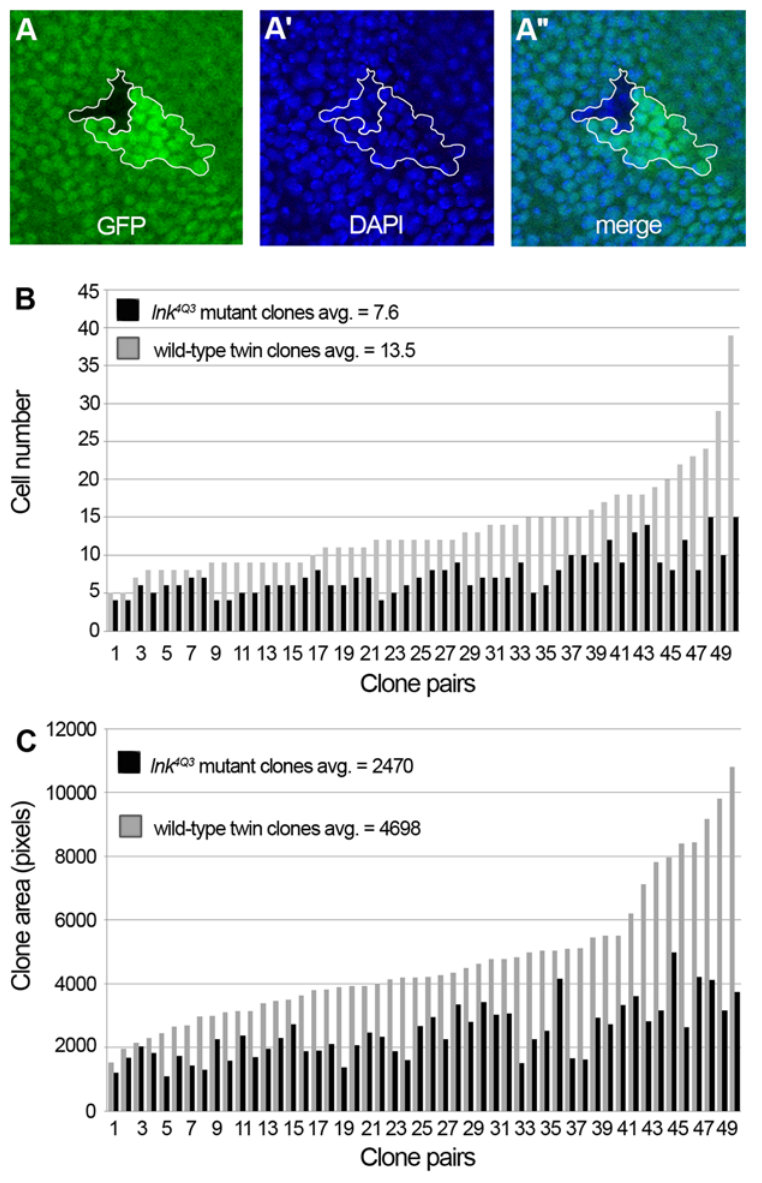
Figure 3. Clones of lnk mutant cells are smaller due to fewer and smaller cells. (A) Twin-spot clone in the wing imaginal disc. A clone consisting of lnk mutant cells (marked by the absence of GFP) and its wild-type sister clone (marked by two copies of GFP) were induced by mitotic recombination using the hsFlp/FRT system. Nuclei are stained with DAPI (A 9 ) and merged with the GFP signal (A 0 ). Clones of lnk mutant cells consist of fewer cells (B) and cover smaller areas (C) than their corresponding wild-type sister clones, indicating that lnk is required for proper cellular growth during development.